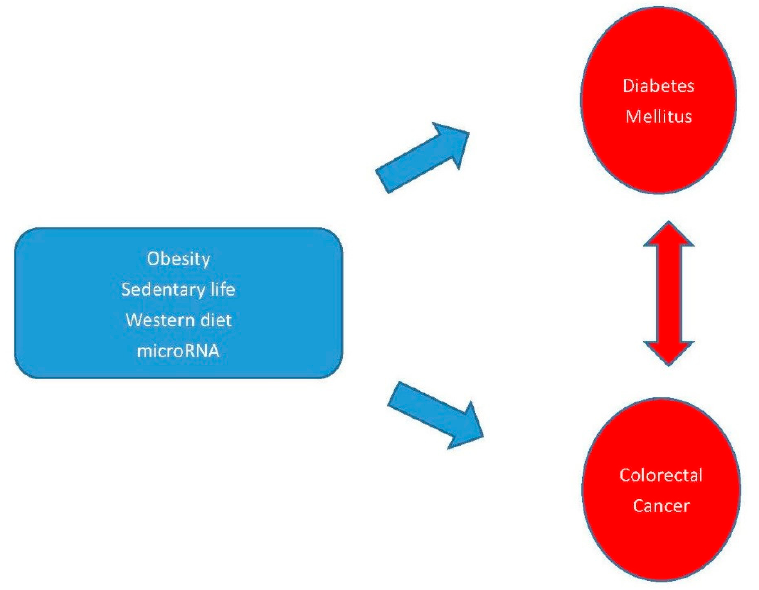
Figure 1. Some common risk factors and genetic factors of DM and CRC . The blue arrows show the risk factors cause to DM and CRC and the red arrow shows there is a relationship between DM and